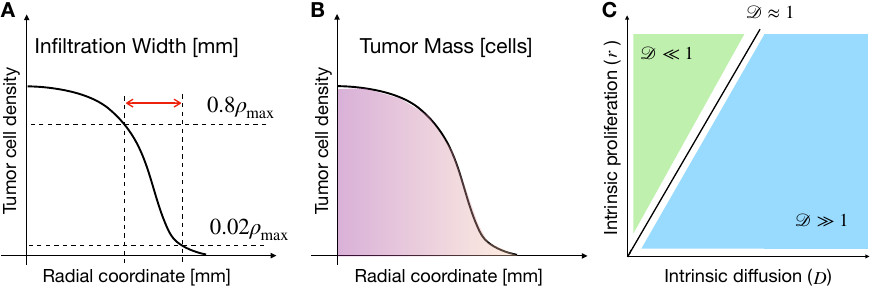
Figure 3. Graphical representation of model observables and glioma characteristics. Schemes representing tumor infiltration width (IW) ( A ) and tumor mass (TM) ( B ), describing tumor invasiveness and burden in the surrounding tissue, respectively. ( C ) Characteristics of gliomas across the cellular intrinsic diffusion and proliferation space. The relative importance of cell migration to proliferation r − 1 , which splits the plane in regions where is described by the non-dimensional number D ≡ D (cid:96) − 2 t proliferation (green) or migration (blue) dominate